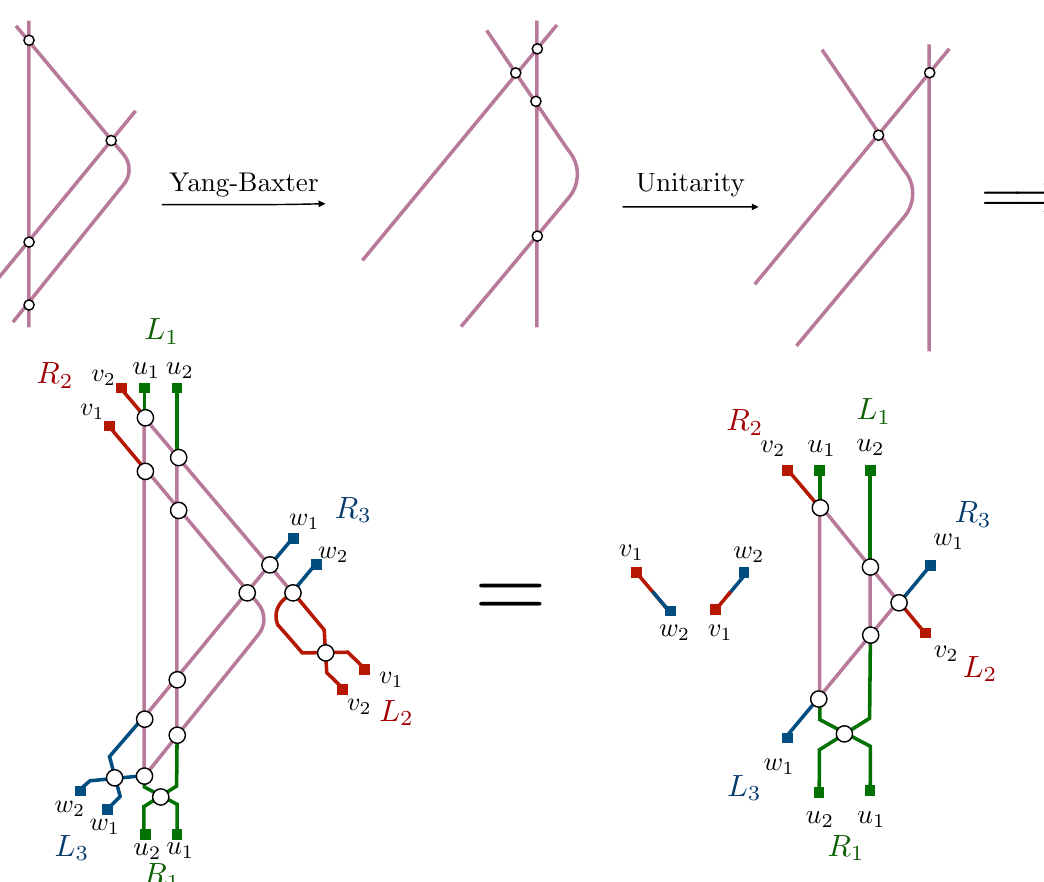
Figure 4 . Decoupling limit in the Z 2 , 2 , 2 case. Top: lines can be disentangled through the basic Yang-Baxter and Unitarity moves. Bottom: when v tation operator, see equation (2.10). One can then use the basic moves (2.7), (2.8) to completely factorize the depende on v unitarity identities h ( v (cid:8)